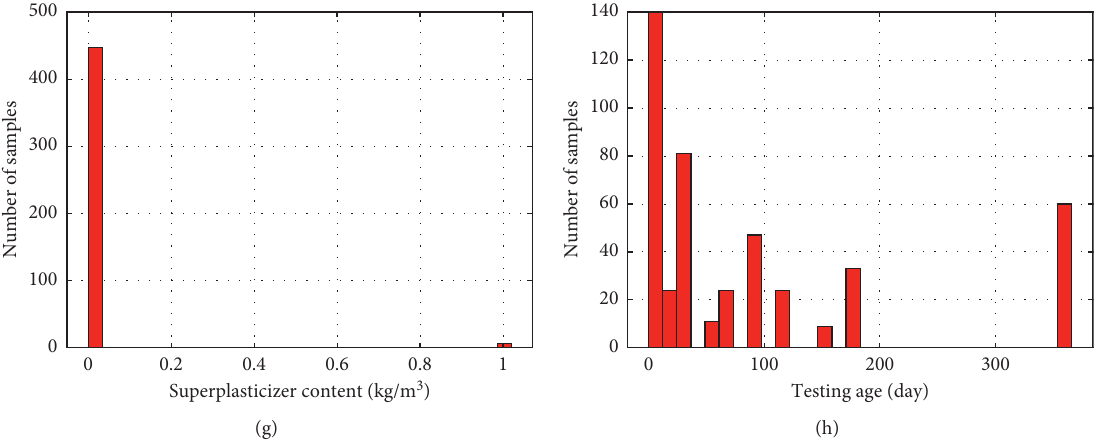
Figure 1: Histograms of the input variables used in this study: (a) cement content; (b) water content; (c) coarse aggregate content; (d) fine aggregate (or sand) content; (e) ground granulated blast furnace slag content; (f) carboxylic-type hyperplasticizing content; (g) super- plasticizer content; and (h) testing age of samples.